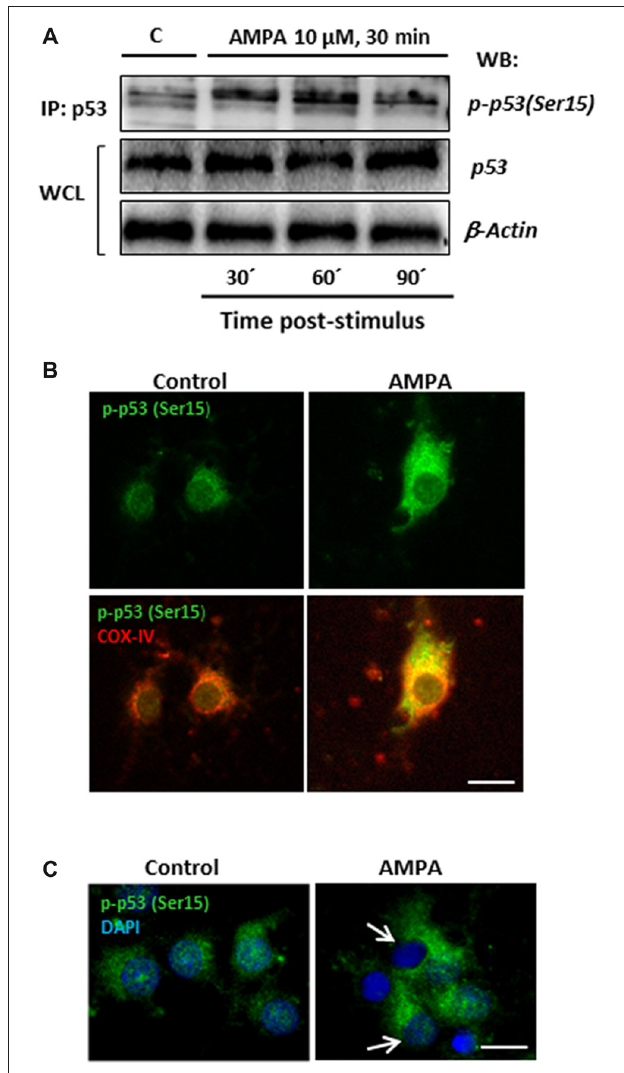
FIGURE 8 | AMPA leads to sustained p53 activation through its phosphorylation in Ser15 and its mitochondrial accumulation. (A) Immunoprecipitation assays were performed in cultured oligodendrocytes after AMPA receptor activation with 10 µ M AMPA plus100 µ M CTZ for 30 min. Cell lysates from oligodendrocytes were harvested at 30, 60 and 90 min post-stimulus and immunoprecipitated with a mouse anti-p53 antibody (total p53; IP:p53). Immunoprecipitates were analyzed by WB using the rabbit antibody against phospho-p53 (Ser15). Total p53 and β -actin in WCL were used as internal loading controls. The image corresponds to one representative immunoprecipitation assay where it is observed an increase in the p53 phosphorylation in Ser15 in response to excitotoxic insults in cultured oligodendrocytes. (B) AMPA induced mitochondrial accumulation of phospho-p53 (Ser15). Oligodendrocytes were treated for 30 min with 10 µ M AMPA plus 100 µ M CTZ and fixed and processed for immunofluorescence using the specific antibody phospho-p53 (Ser15), which only recognizes p53 when it is phosphorylated at this residue (green), and COX-IV antibody to detect mitochondria (red). Exposure to AMPA triggered p-p53 (Ser15) increase with cellular localization coincident with the mitochondrial environment (yellow). Scale bar, 10 µ m. (C) Immunofluorescence images of oligodendrocytes control and exposed to AMPA where it is remarkable the accumulation of p-p53 (Ser15) induced by AMPA as well as the total absence of p-p53 (Ser15) in the nuclei, contrasted with DAPI (arrows). Scale bar: 10 µ